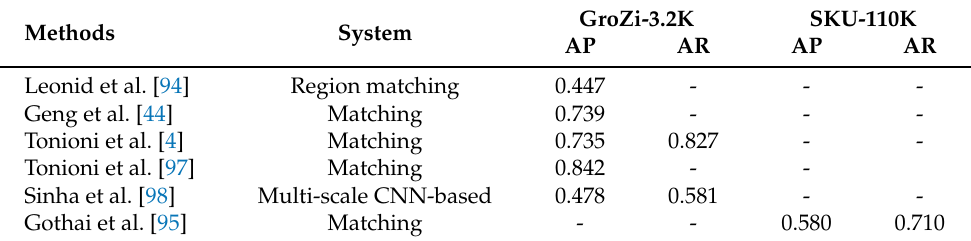
Table 6. Evaluation and comparison of grocery detection and recognition methods on GroZi-